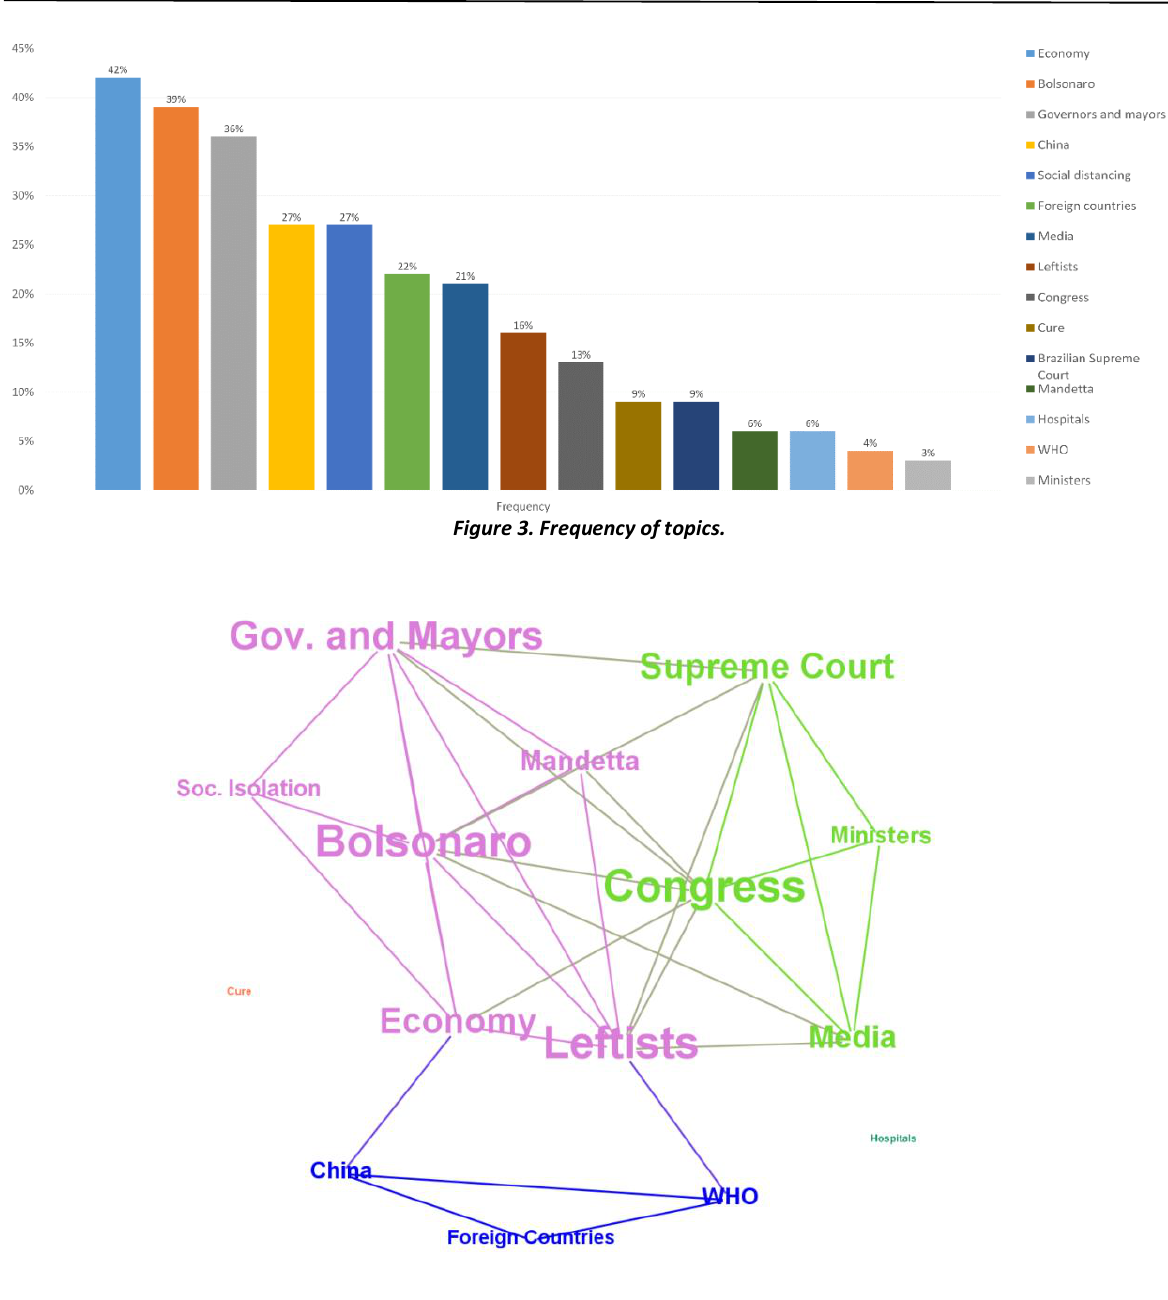
Figure 4. Network of correlated topics in the